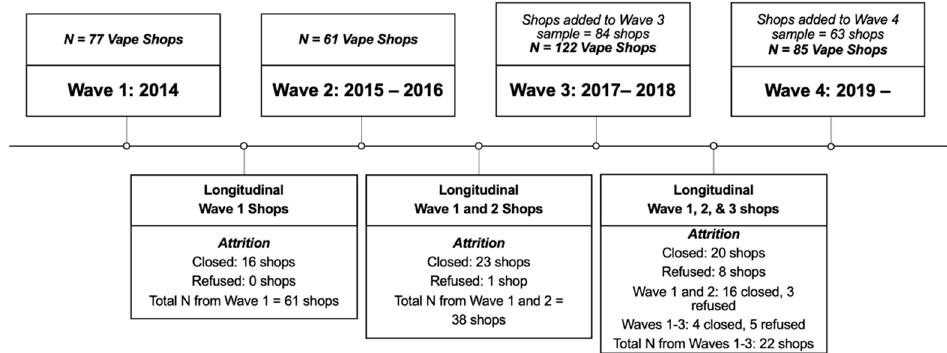
Figure 2. Data Collection Timeline.